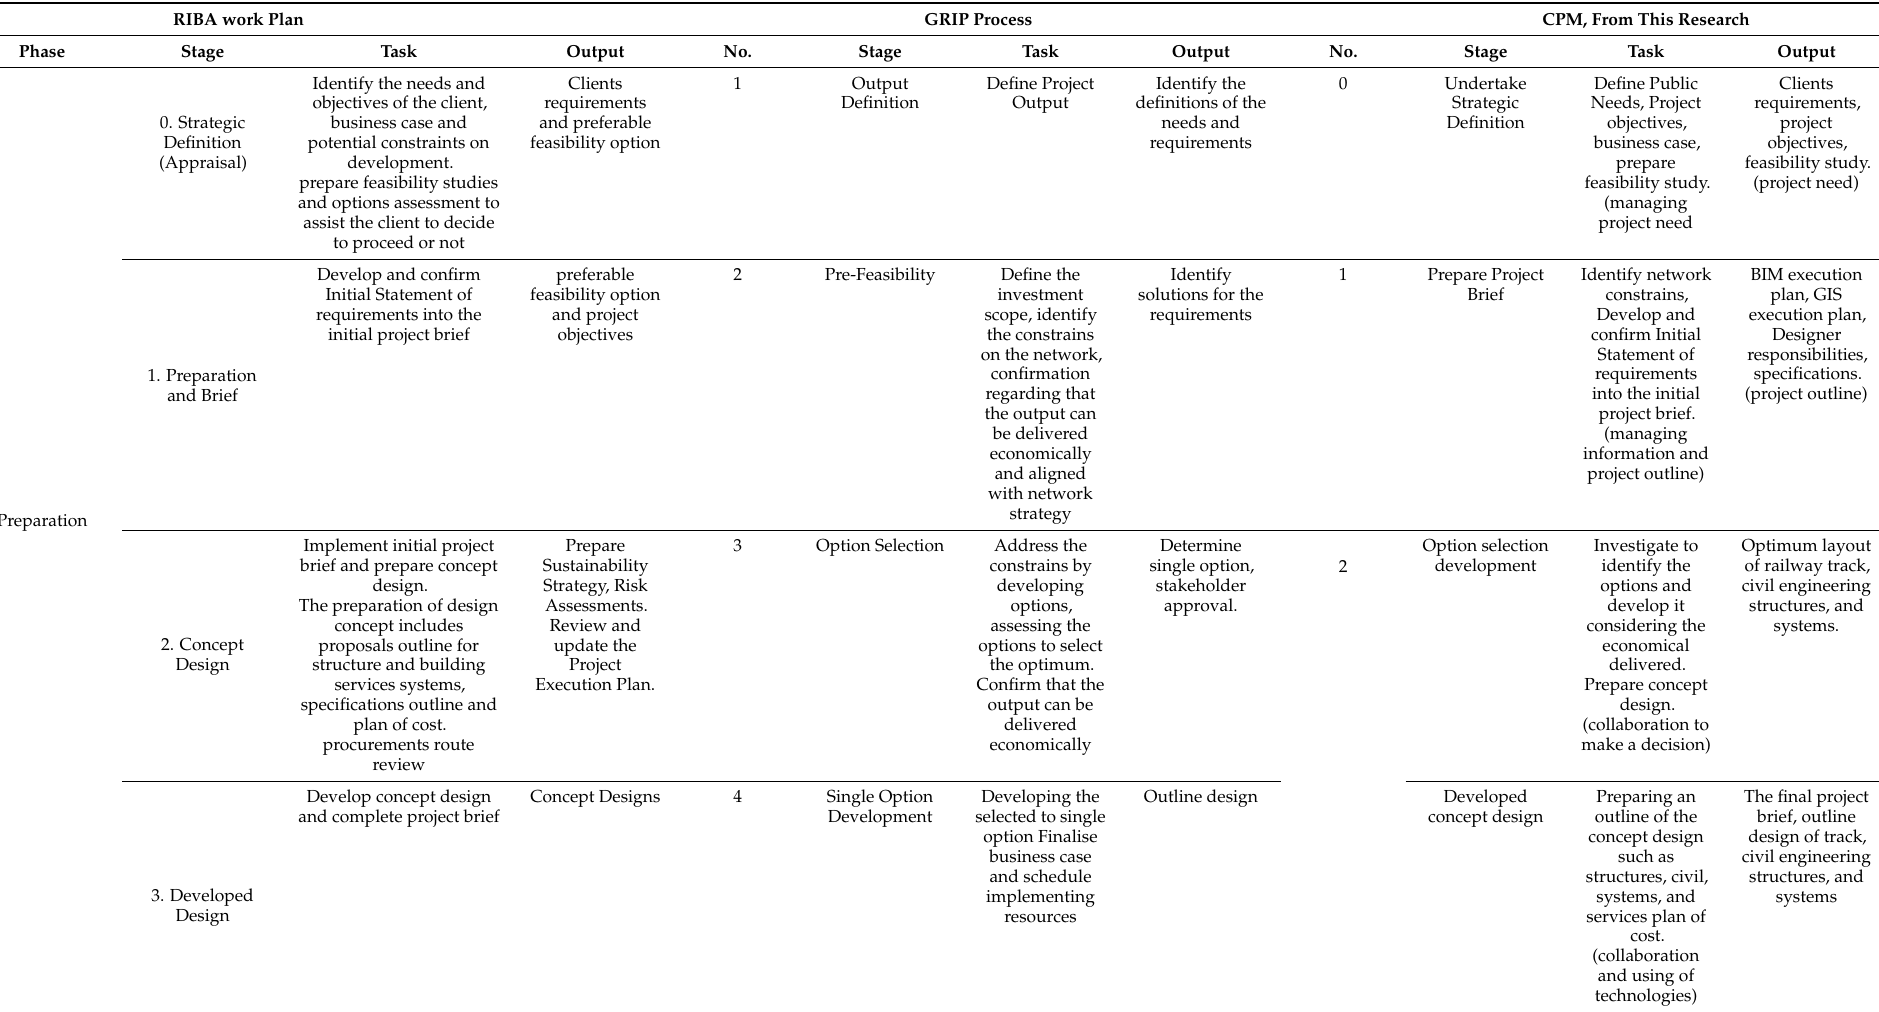
Table 4. Developed Collaborative Plan of Work